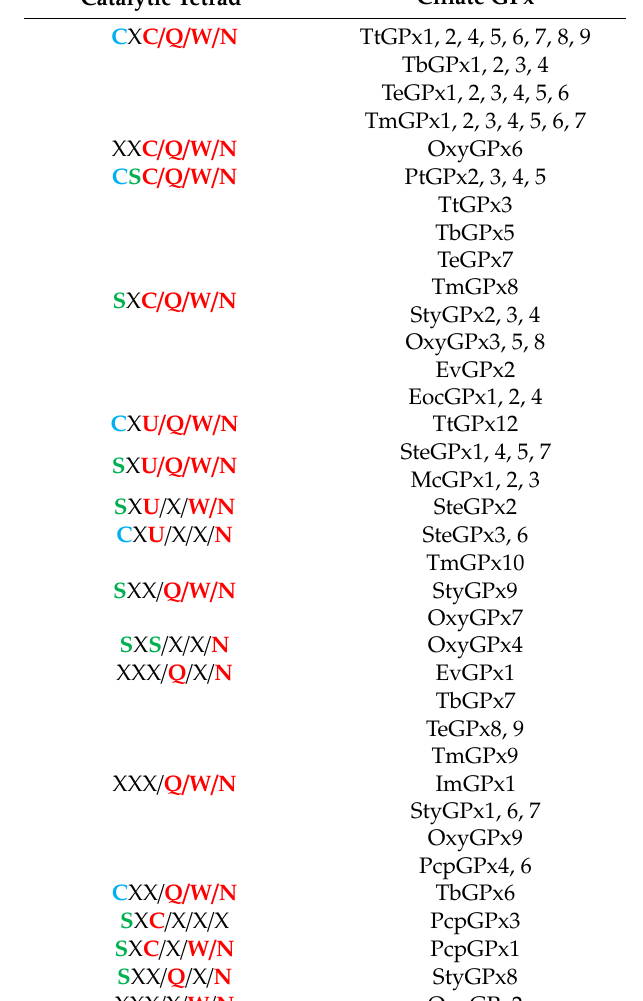
Table 2. Catalytic tetrad conserved motifs from putative ciliate